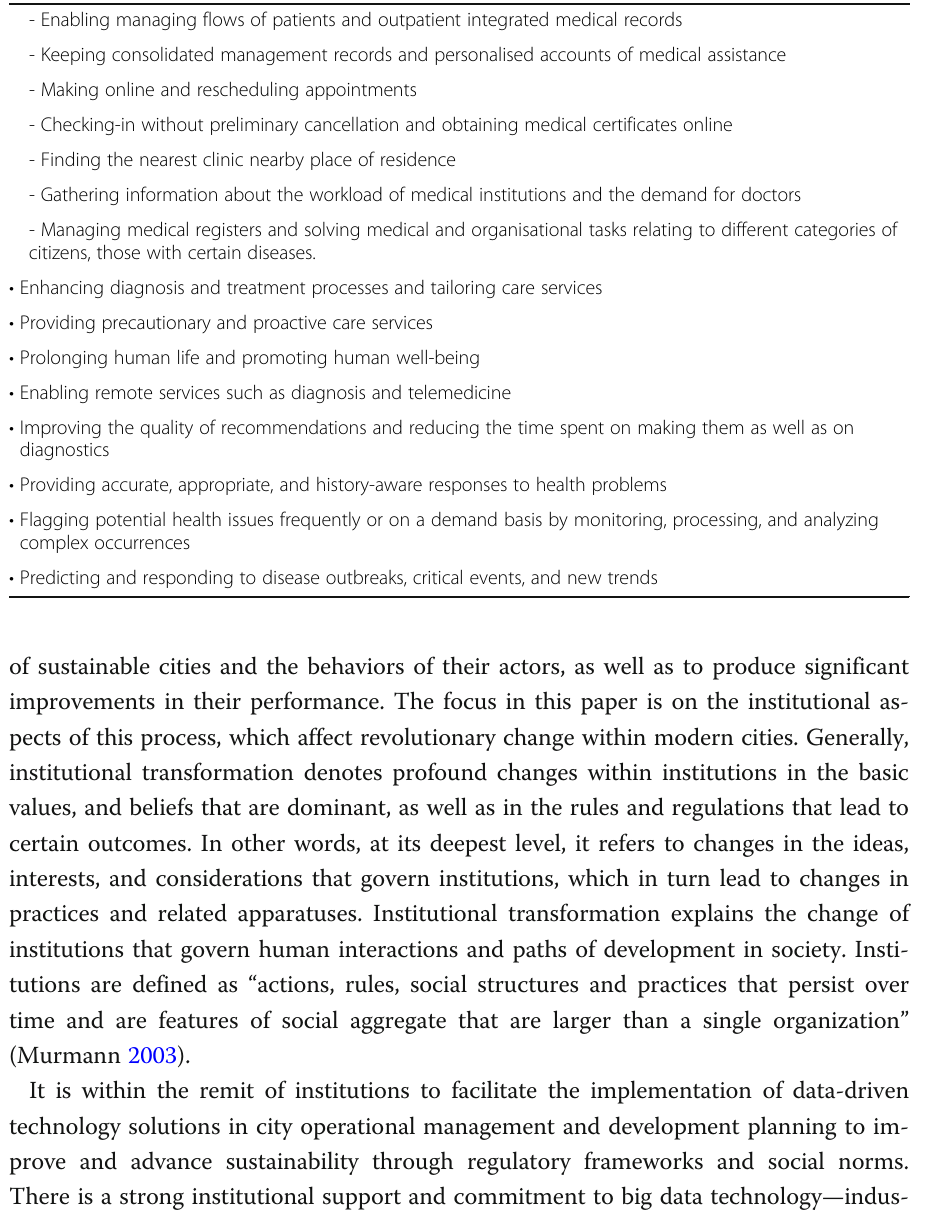
Table 6 The key benefits, potentials, and opportunities of the data-driven smart city and the environmentally data-driven smart sustainable city